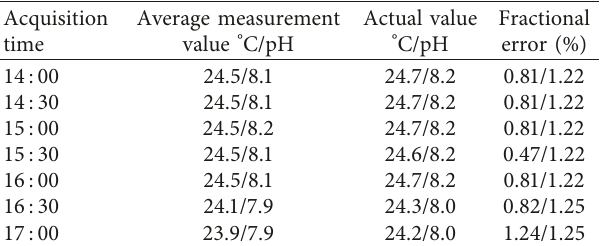
Table 4: Comparison of the experimental and actual measured values of the